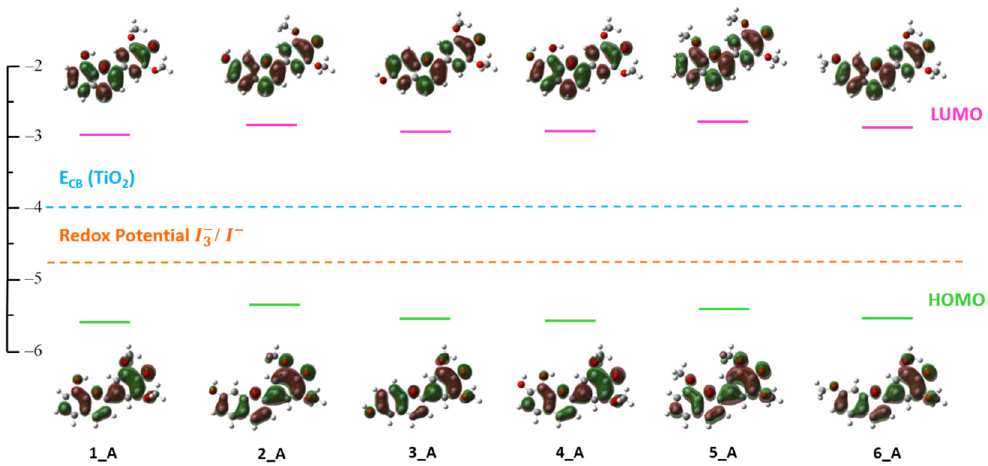
Figure 6. Energy level diagram for the dyes (quinoidal bases A).